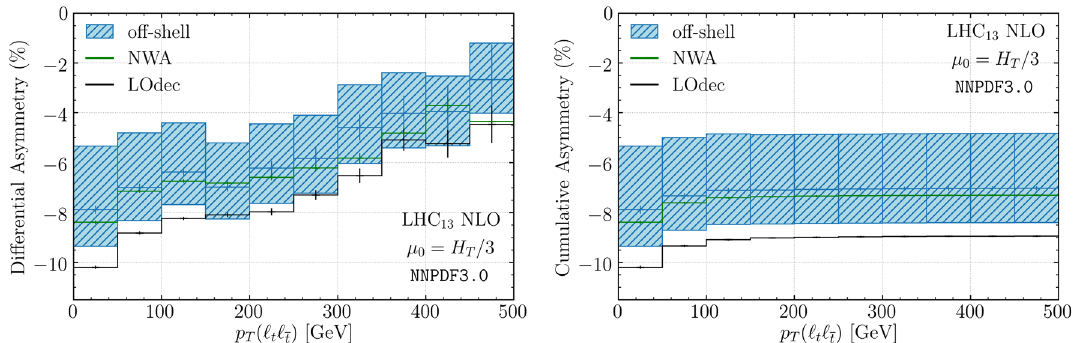
Fig. 7 The p T ((cid:4) t (cid:4) ¯ t ) -dependentdifferential(leftpanel)andcumulative (right panel) A (cid:4) c asymmetry at NLO QCD for pp → t ¯ tW ± in the multi- lepton channel at the LHC with the modelling of the top quark production and decays are considered.